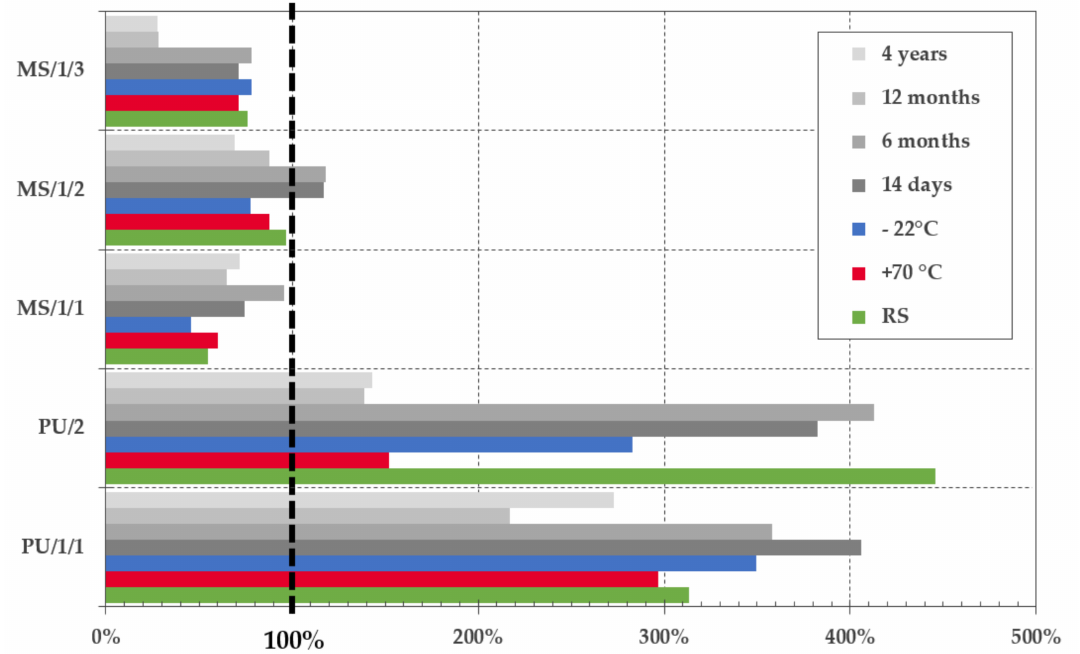
Figure 7. Comparison of the tensibility after artificial and real aging of samples from the I and II project phase—i.e. design A.